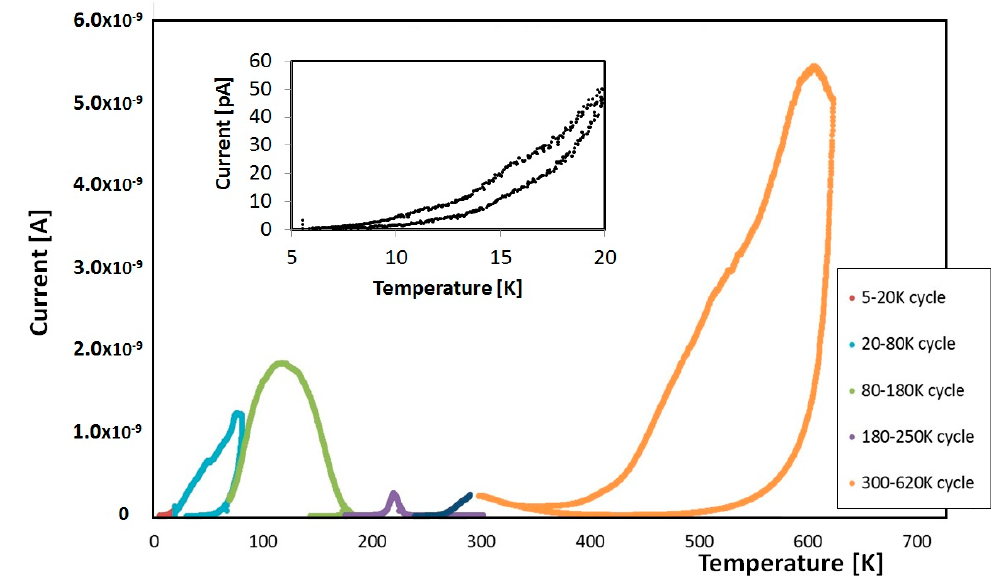
Figure 3. Fractionated TSC analysis performed in different cycles of measurements after ultraviolet (UV) priming at 5 K. Inset on the left shows an enlarged view of the 5–20 K temperature range. Main conductivity processes in the two temperature ranges 5–300 K and 300–630 K are different.